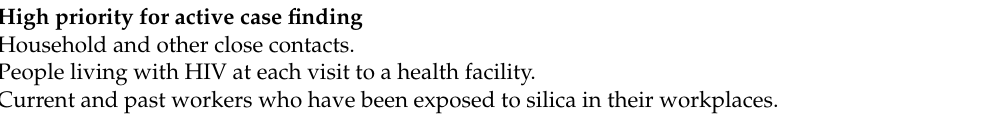
Table 3. Active tuberculosis case finding for high-risk or vulnerable